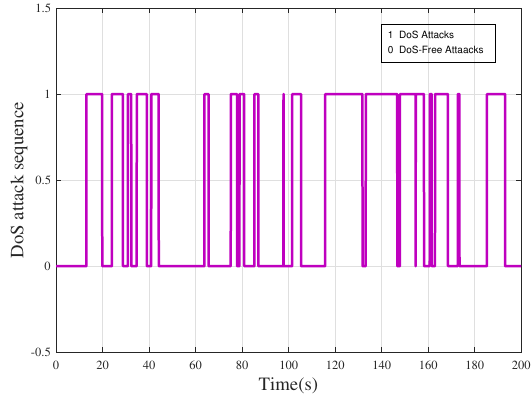
Figure 13. Aperiodic DoS